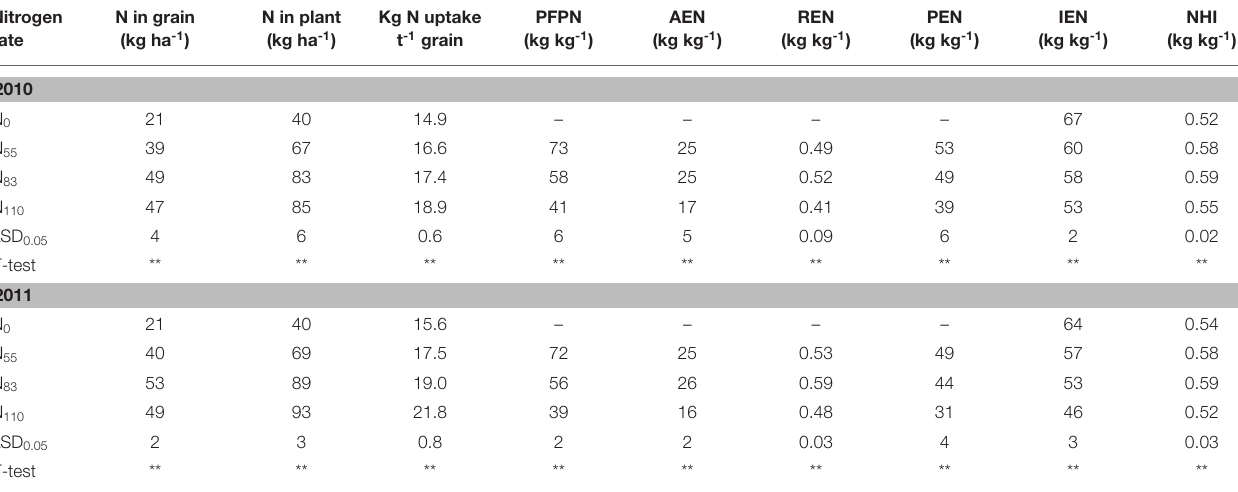
TABLE 4 | Effect of N rate on its content and use efficiencies (averages across tested genotypes). Nitrogen N in grain rate (kg ha -1 )